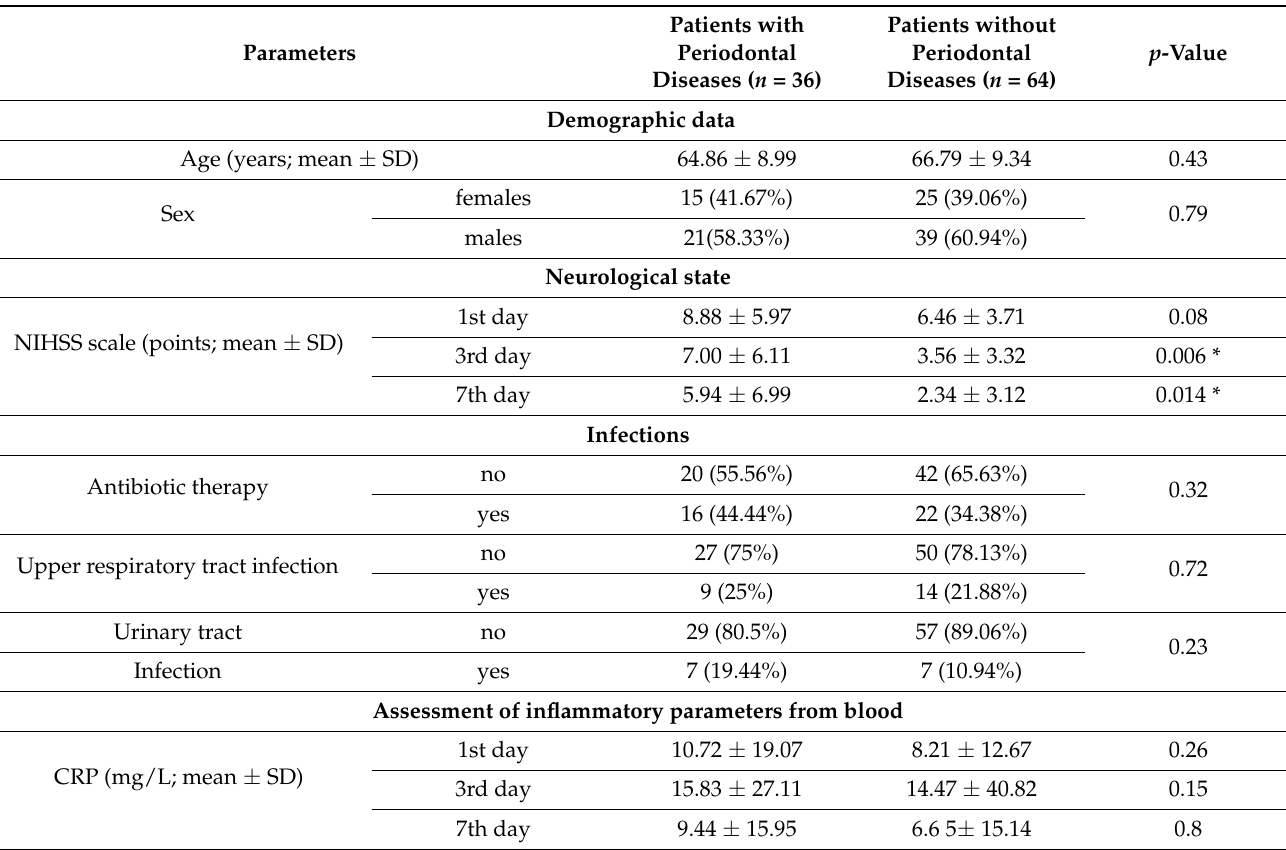
Table 2. Characteristics of stroke patients treated with and without periodontal disease.